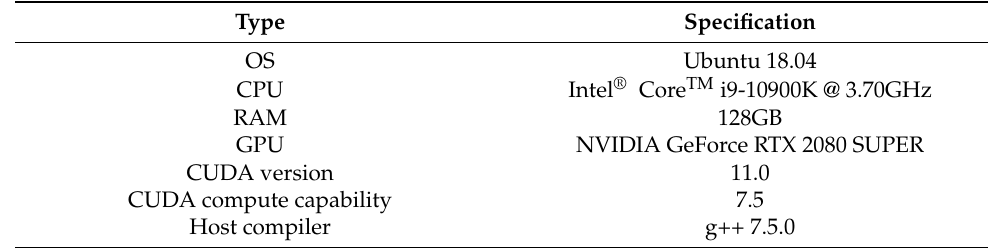
Table 5. Hardware and software specification for experiment environment.